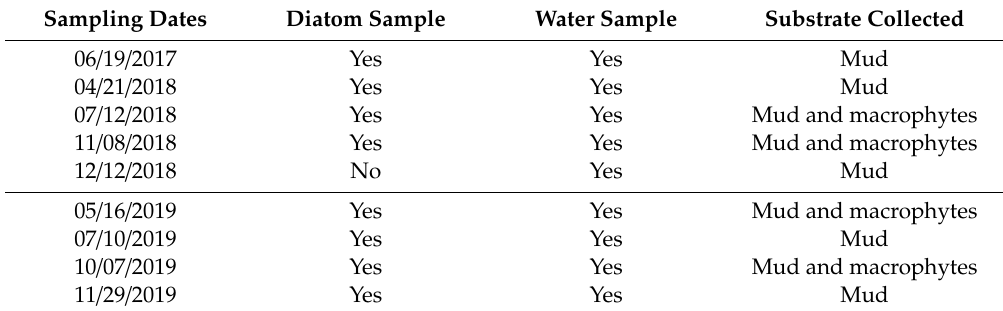
Table 1. Sampling dates, analyses done on the samples, and substrate collected for diatoms. Sampling